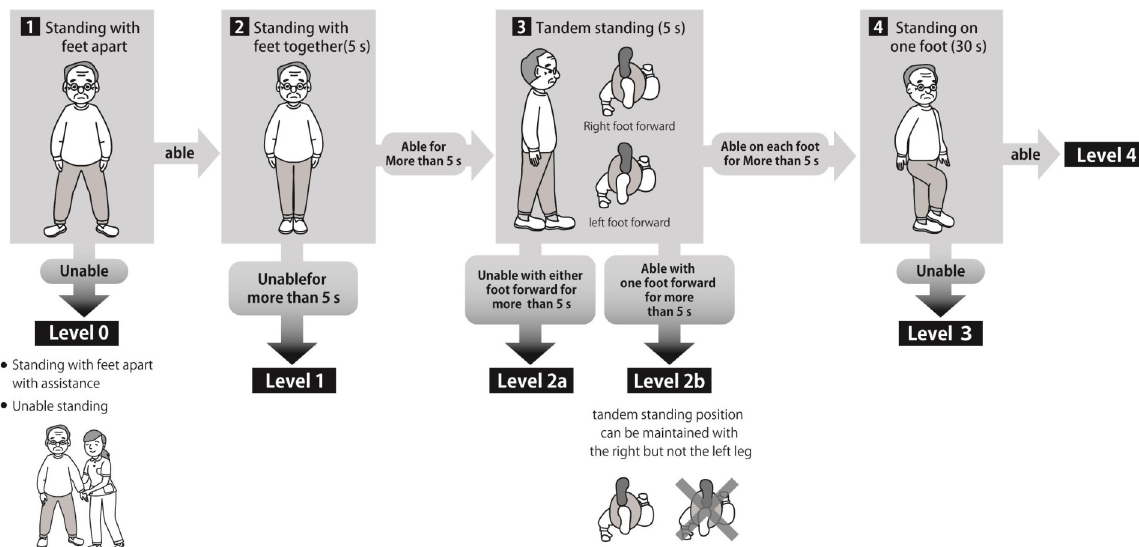
Fig 2. Standing Test for Imbalance and Disequilibrium (SIDE). The patients perform the static balance test in the following order, standing with feet apart, standing with feet together, tandem standing, and standing on one foot. After checking which movements are possible or impossible for the patient, the medical staff assesses the patients into six levels: Level 0, 1, 2a, 2b, 3, and 4. Level 0: The patient can’t stand with feet apart without assistance. Level 1: The patient can stand with feet apart without assistance. However, the patients can’t stand with feet together for more than 5 s. Level 2a: The patient can stand with feet together for more than 5 s. However, the patients can’t stand in a tandem position with either foot forward. Level 2b: The patient can stand tandem with one but not the other foot in the leading position for more than 5 s. Level 3: The patient can stand tandem standing with each foot forward for more than 5 s. However, the patient can’t stand on one foot more than 30 s. Level 4: The patient can stand on one foot more than 30 s with either